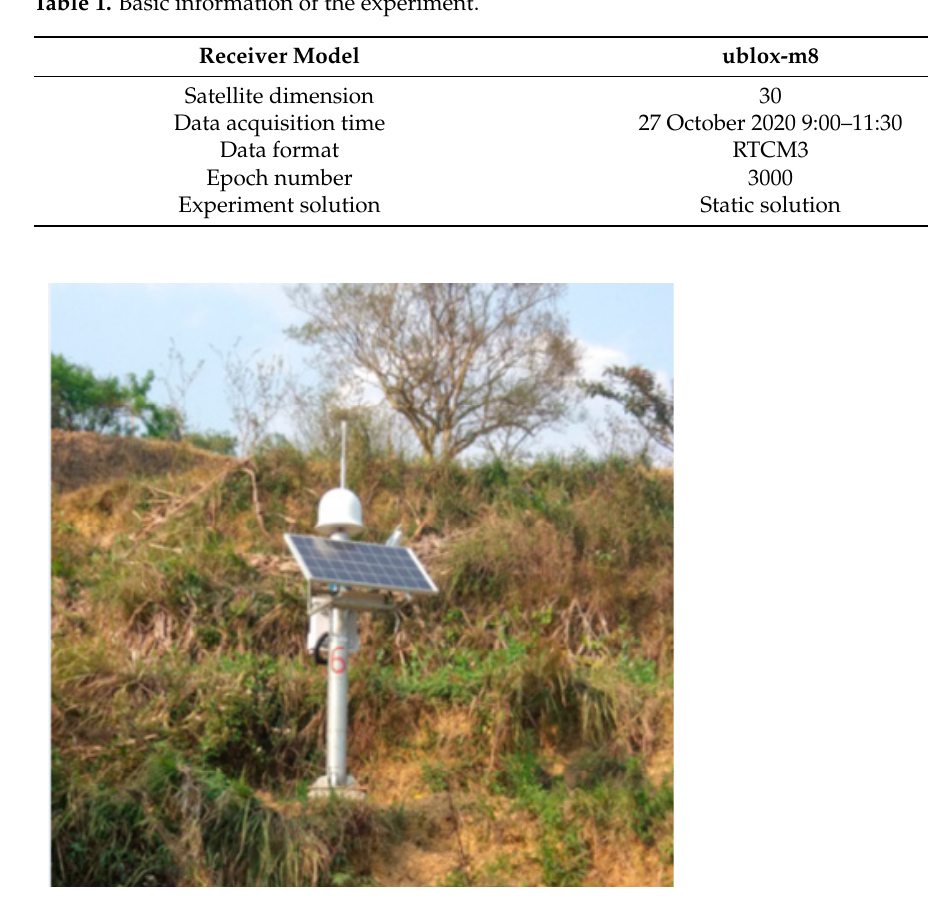
Figure 6. Experimental data collection stations.